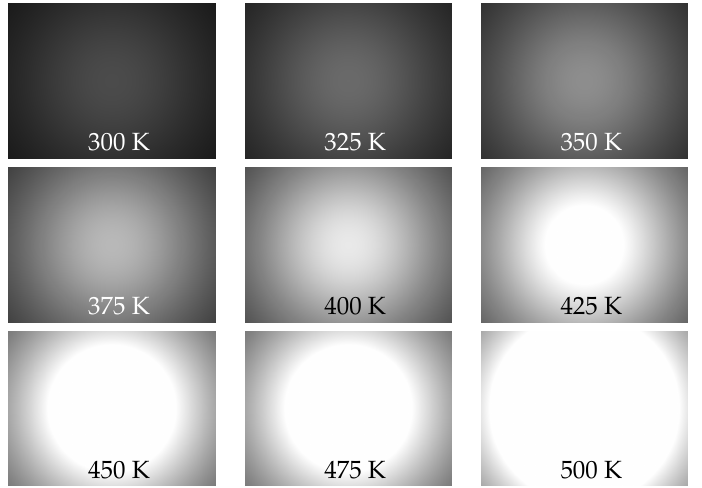
Figure 7. Visualization of IR power distribution over sensor area following cos 4 β law at different BB